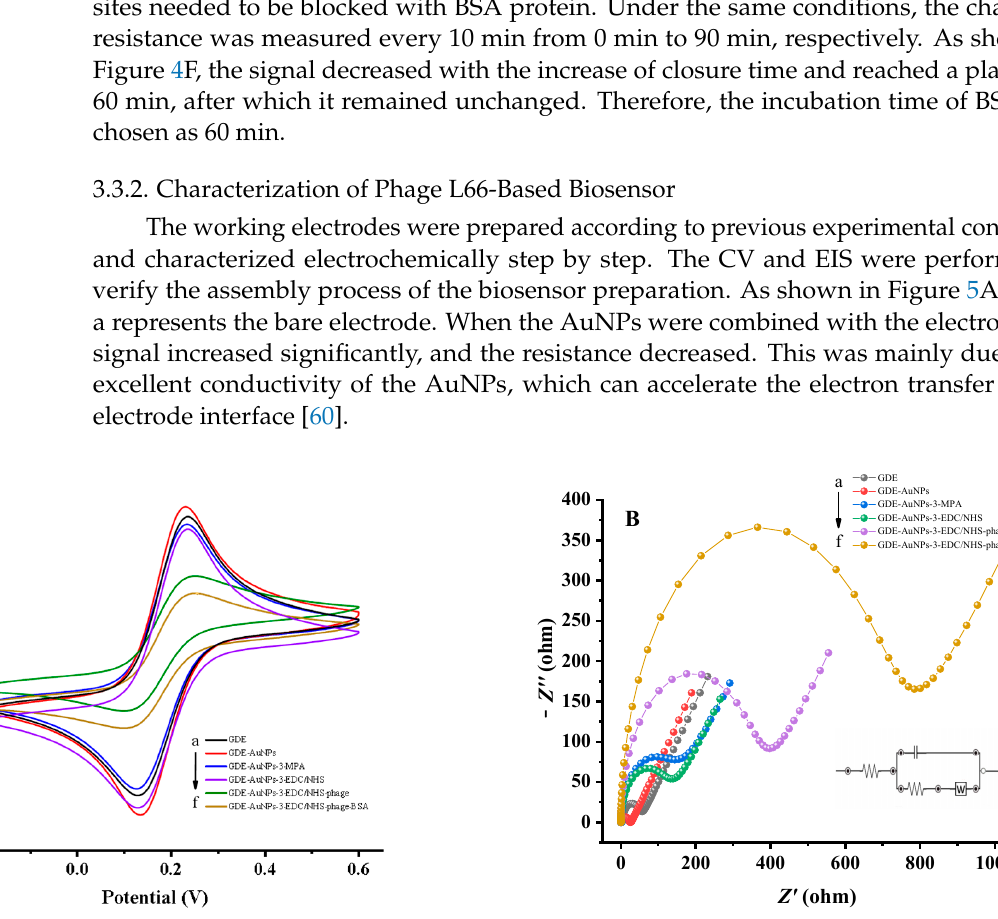
Figure 5. Electrochemical characterization of GDE-AuNPs-MPA-EDC/NHS-Phage. ( A ) CV scan of the biosensor construction process. ( B ) EIS scan of the biosensor construction process; the inset was Randles equivalent circuit.